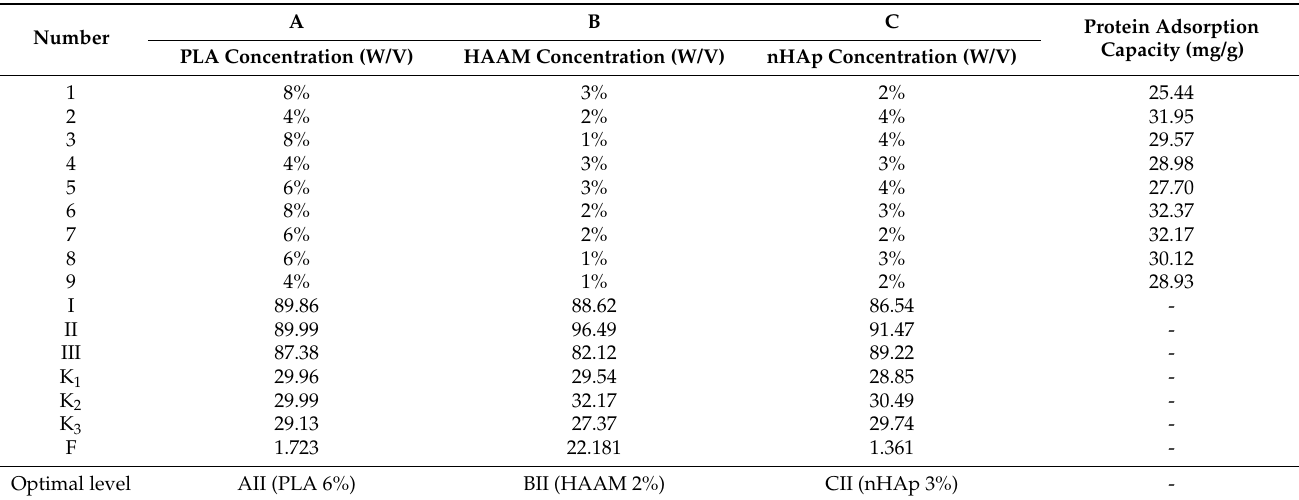
Table 3. Orthogonal test